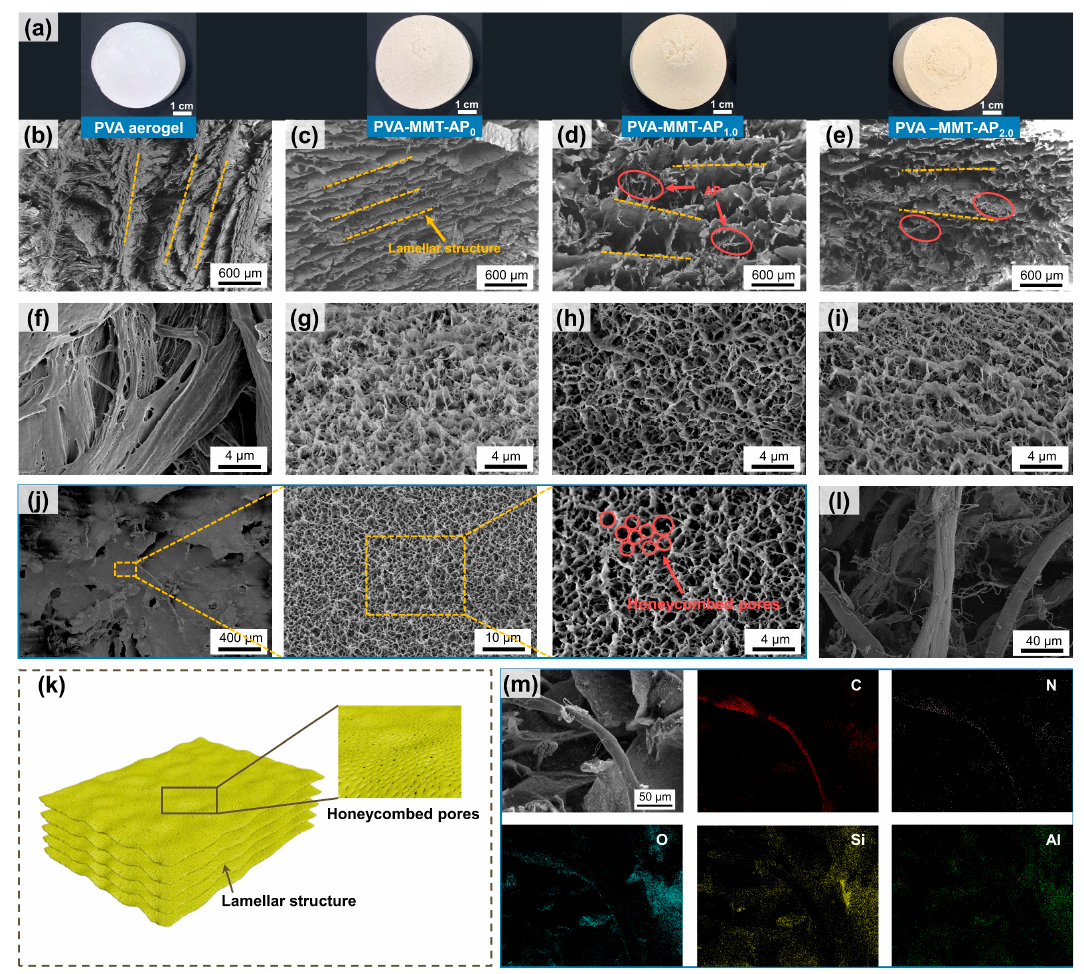
Figure 1. ( a ) The prepared samples from left to right are the PVA aerogel, PVA-MMT-AP 0 , PVA-MMT-AP 1.0 and PVA-MMT-AP 2.0 , respectively. The microstructures of the ( b , f ) PVA aerogel, ( c , g ) PVA-MMT-AP 0 , ( d , h ) PVA-MMT-AP 1.0 and ( e , i ) PVA-MMT-AP 2.0 , respectively. ( j ) The lamella of PVA-MMT-AP 1.0 and ( k ) the schematic illustration of the “lamella-honeycomb” porous network structure. ( l ) AP. ( m ) The element distributions of the PVA-MMT-AP 1.0 .